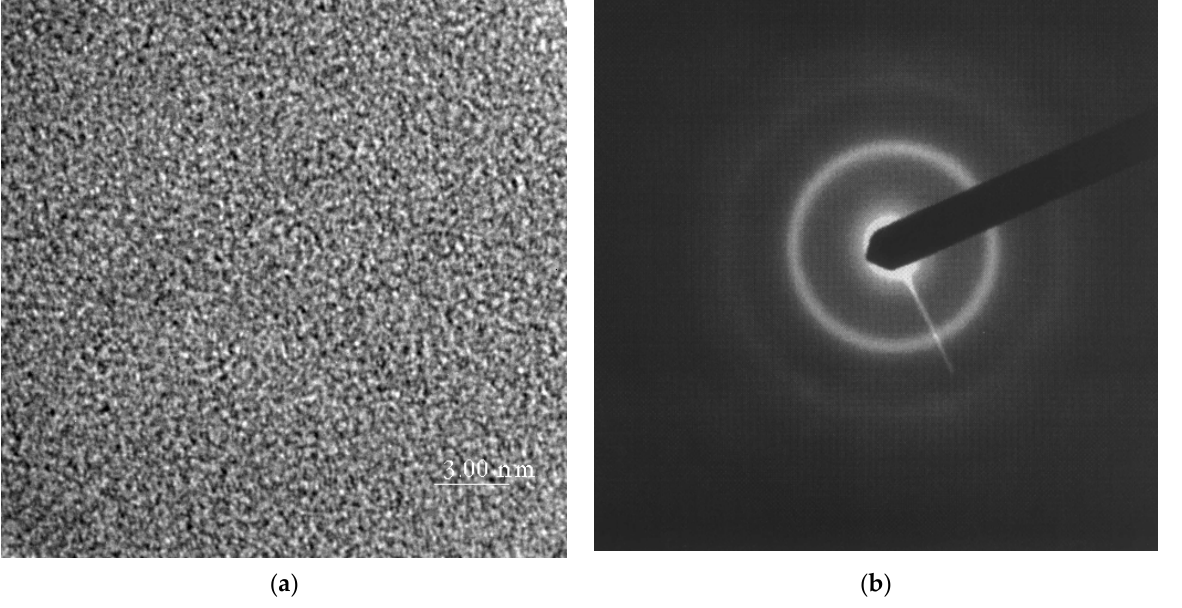
Figure 1. HREM image ( a ) and the corresponding electron diffraction pattern ( b ) for Fe 78 Si 13 B 9 alloy after annealing at T op temperature (623 K/1 h).